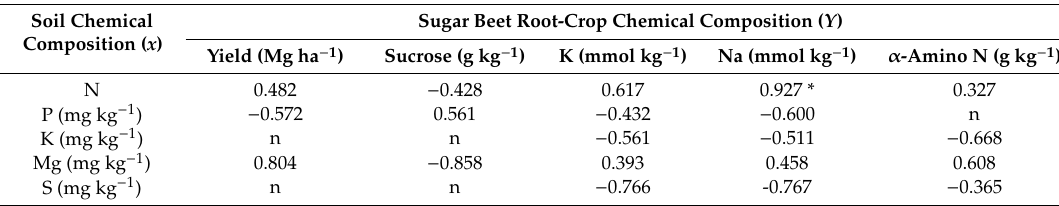
n—weak correlation. *—significant at p <